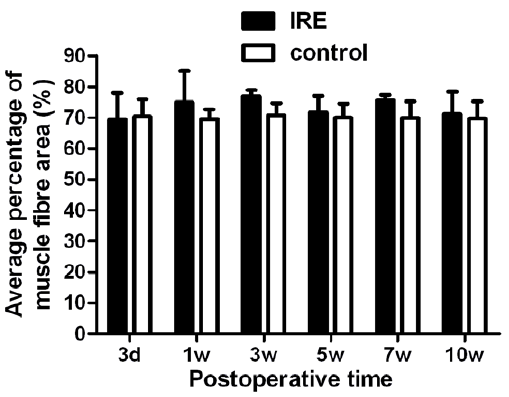
Figure 5. The statistical analysis of the average percentage muscle fiber area. There were no significant differences between IRE and the control.